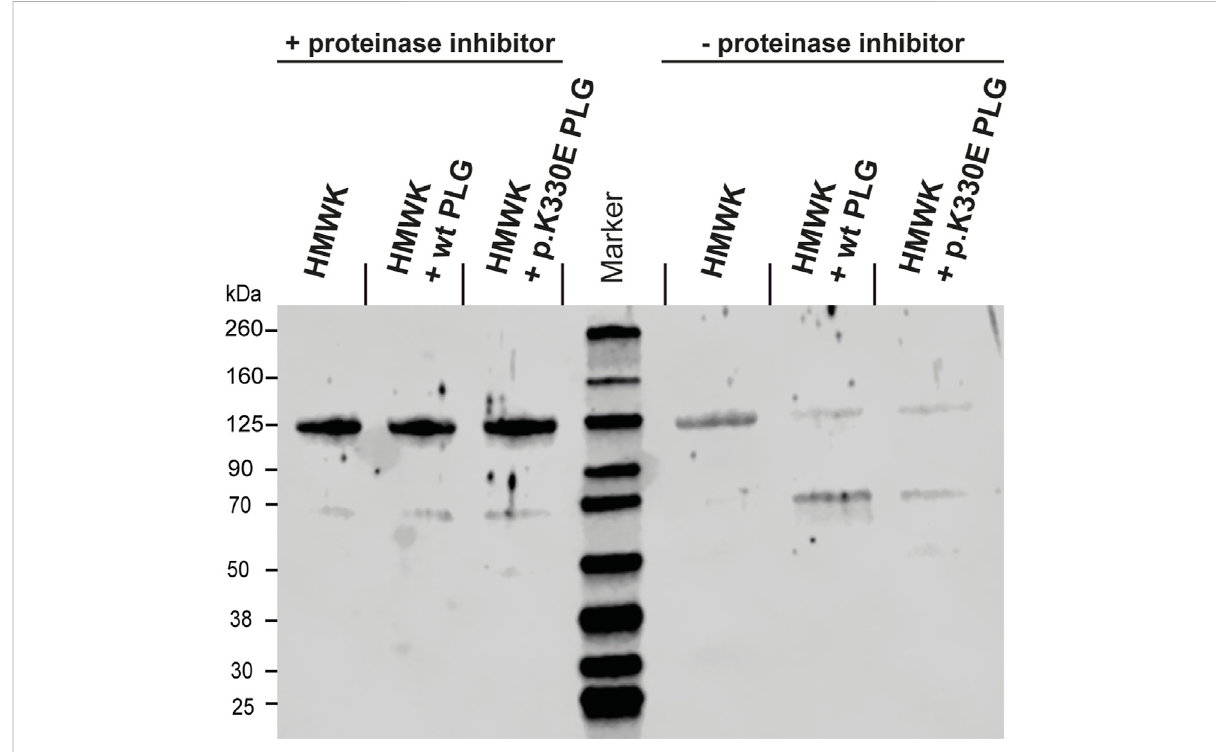
FIGURE 4 Western blot after 22 h of incubations showing HMWK incubated alone, with wt plasminogen, and with mutant plasminogen (p.K330E) in the presence of proteinase inhibitor (left side of the blot) and without proteinase inhibitor (right side).